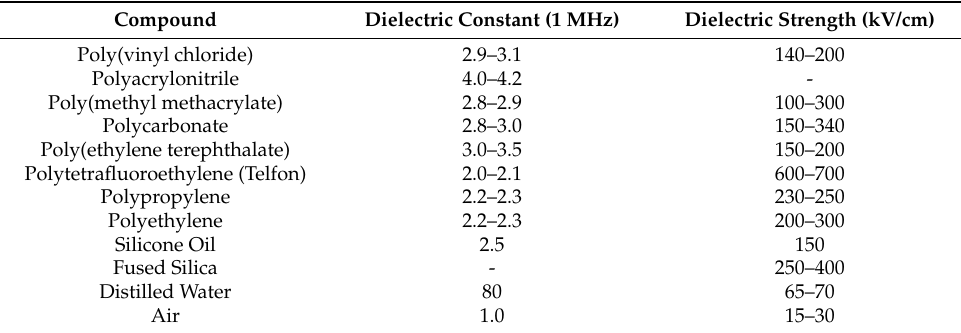
Table 5. Dielectric constant and dielectric strength of some polymers